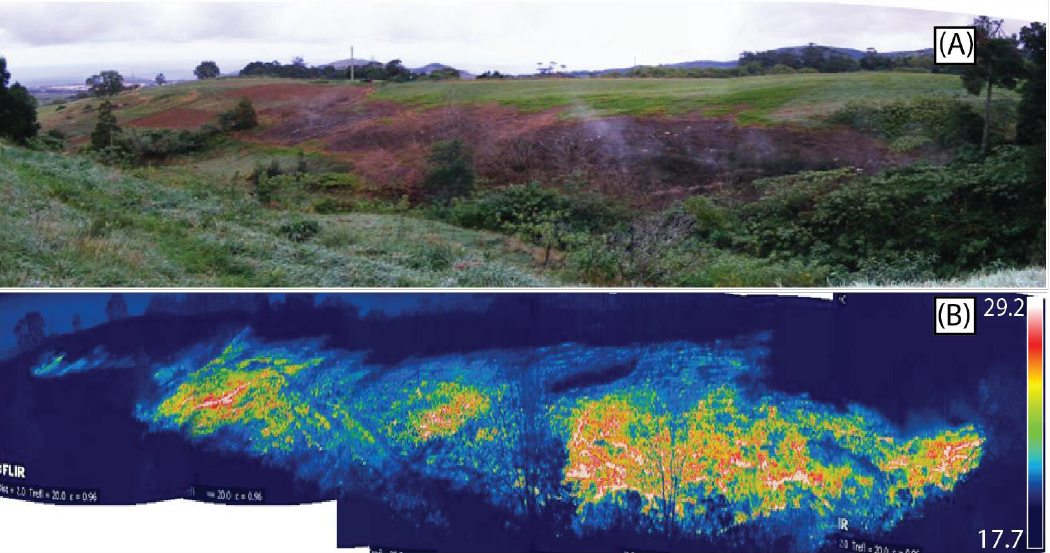
Figure 3. Oblique aerial photo of the degassing area located next to the RG4 well with altered vegetation. ( A ) The visible image shows the altered vegetation associated with the thermal anomaly, and ( B ) the thermal image acquired with a FLIR Therma CAM™ SC640 thermal infrared camera (thermal and visible image provided by IVAR/CIVISA acquired on July 21, 2010).